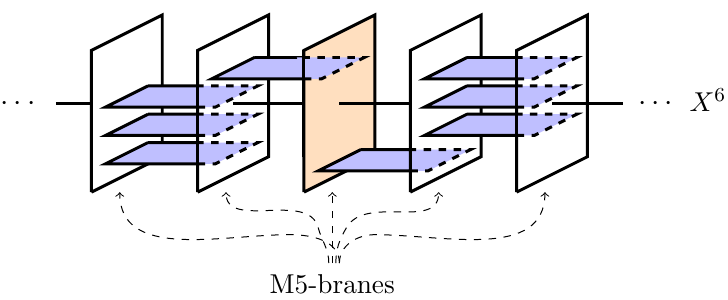
Figure 3 . Con(cid:12)guration of 5 M5-branes with various M2-branes (shown in blue) stretched between them. The M5-brane in the middle (shown in orange) has only one M2-brane ending on either side. The labelling of the coordinate X 6 is explained later on in section